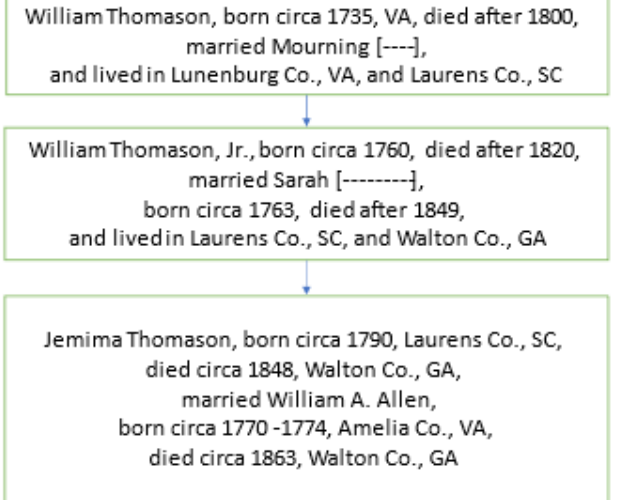
Figure 8. Thomason Ancestry. This chart summarizes the immediate ancestry of Jemima Thomason Allen.